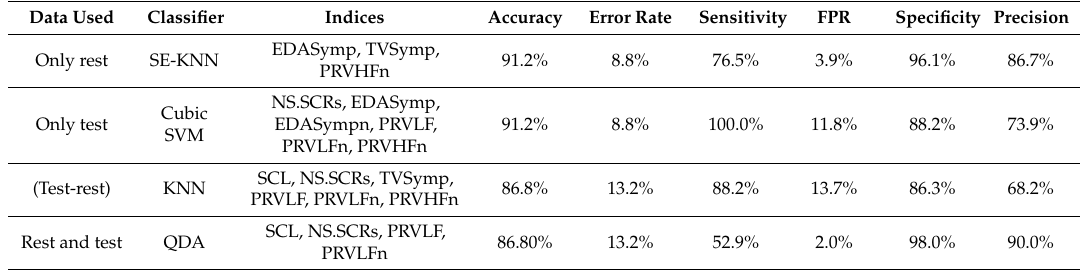
Table 6. Classification results for the most accurate models for each case.